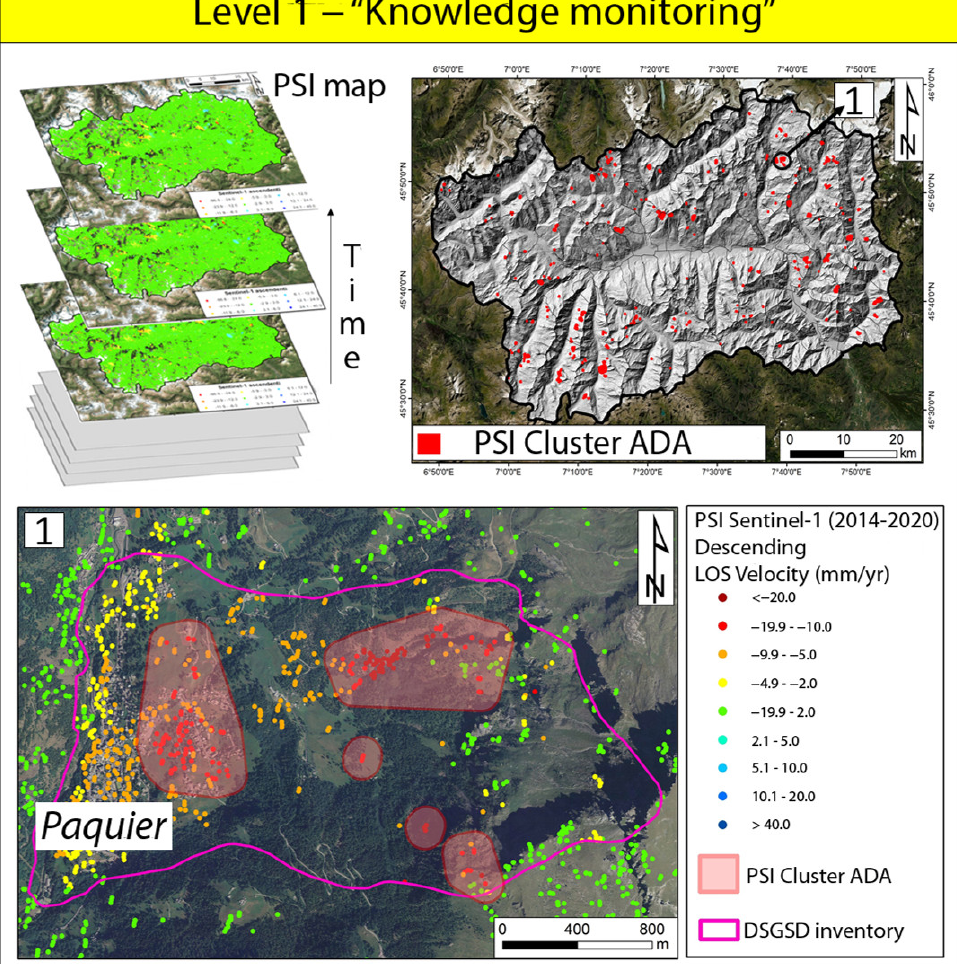
Figure 2. Level 1—“Knowledge monitoring”: Concept of “PS mapping” activity ( top-left box ); distribution of Persistent Scatterer Interferometry (PSI) clusters named as Active Deformation Areas (ADA) for October 2014–August 2020 over the VAR ( top-right box ); example of PSI ADA clusters whose location is shown in the up-right box ( lower box